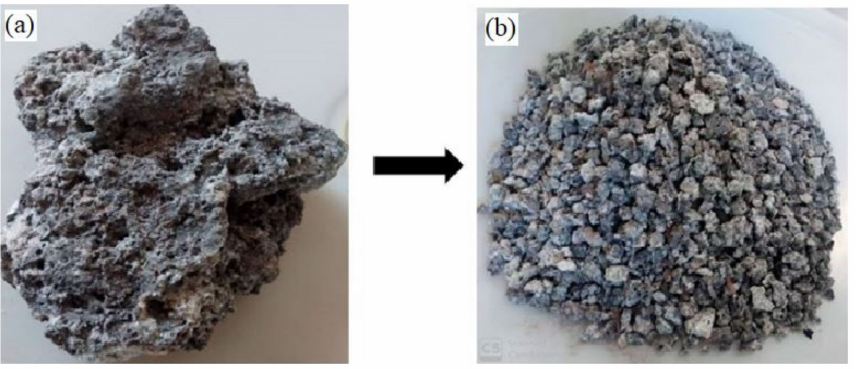
Figure 1. ( a ) Chunk and ( b ) grounded form of palm oil clinker.